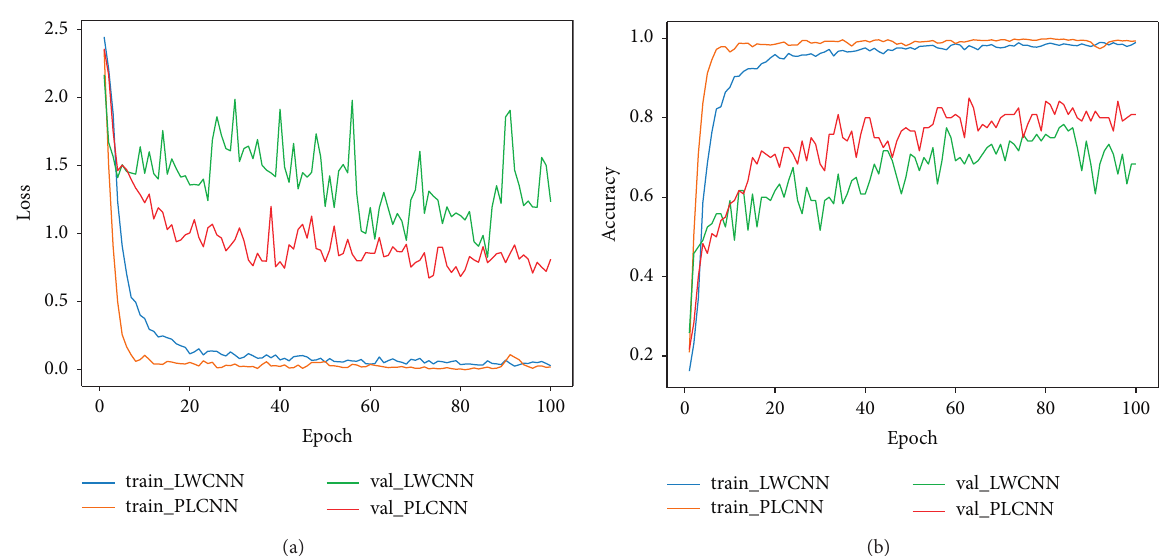
Figure 12: Loss function trend chart and precision change trend chart for Exercise A: (a) loss tend; (b) accuracy